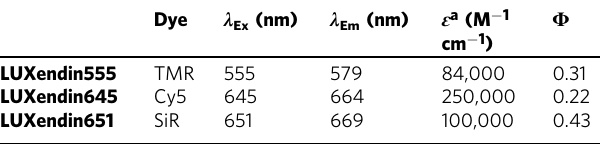
Table 1 Spectral properties of GLP1R labeling